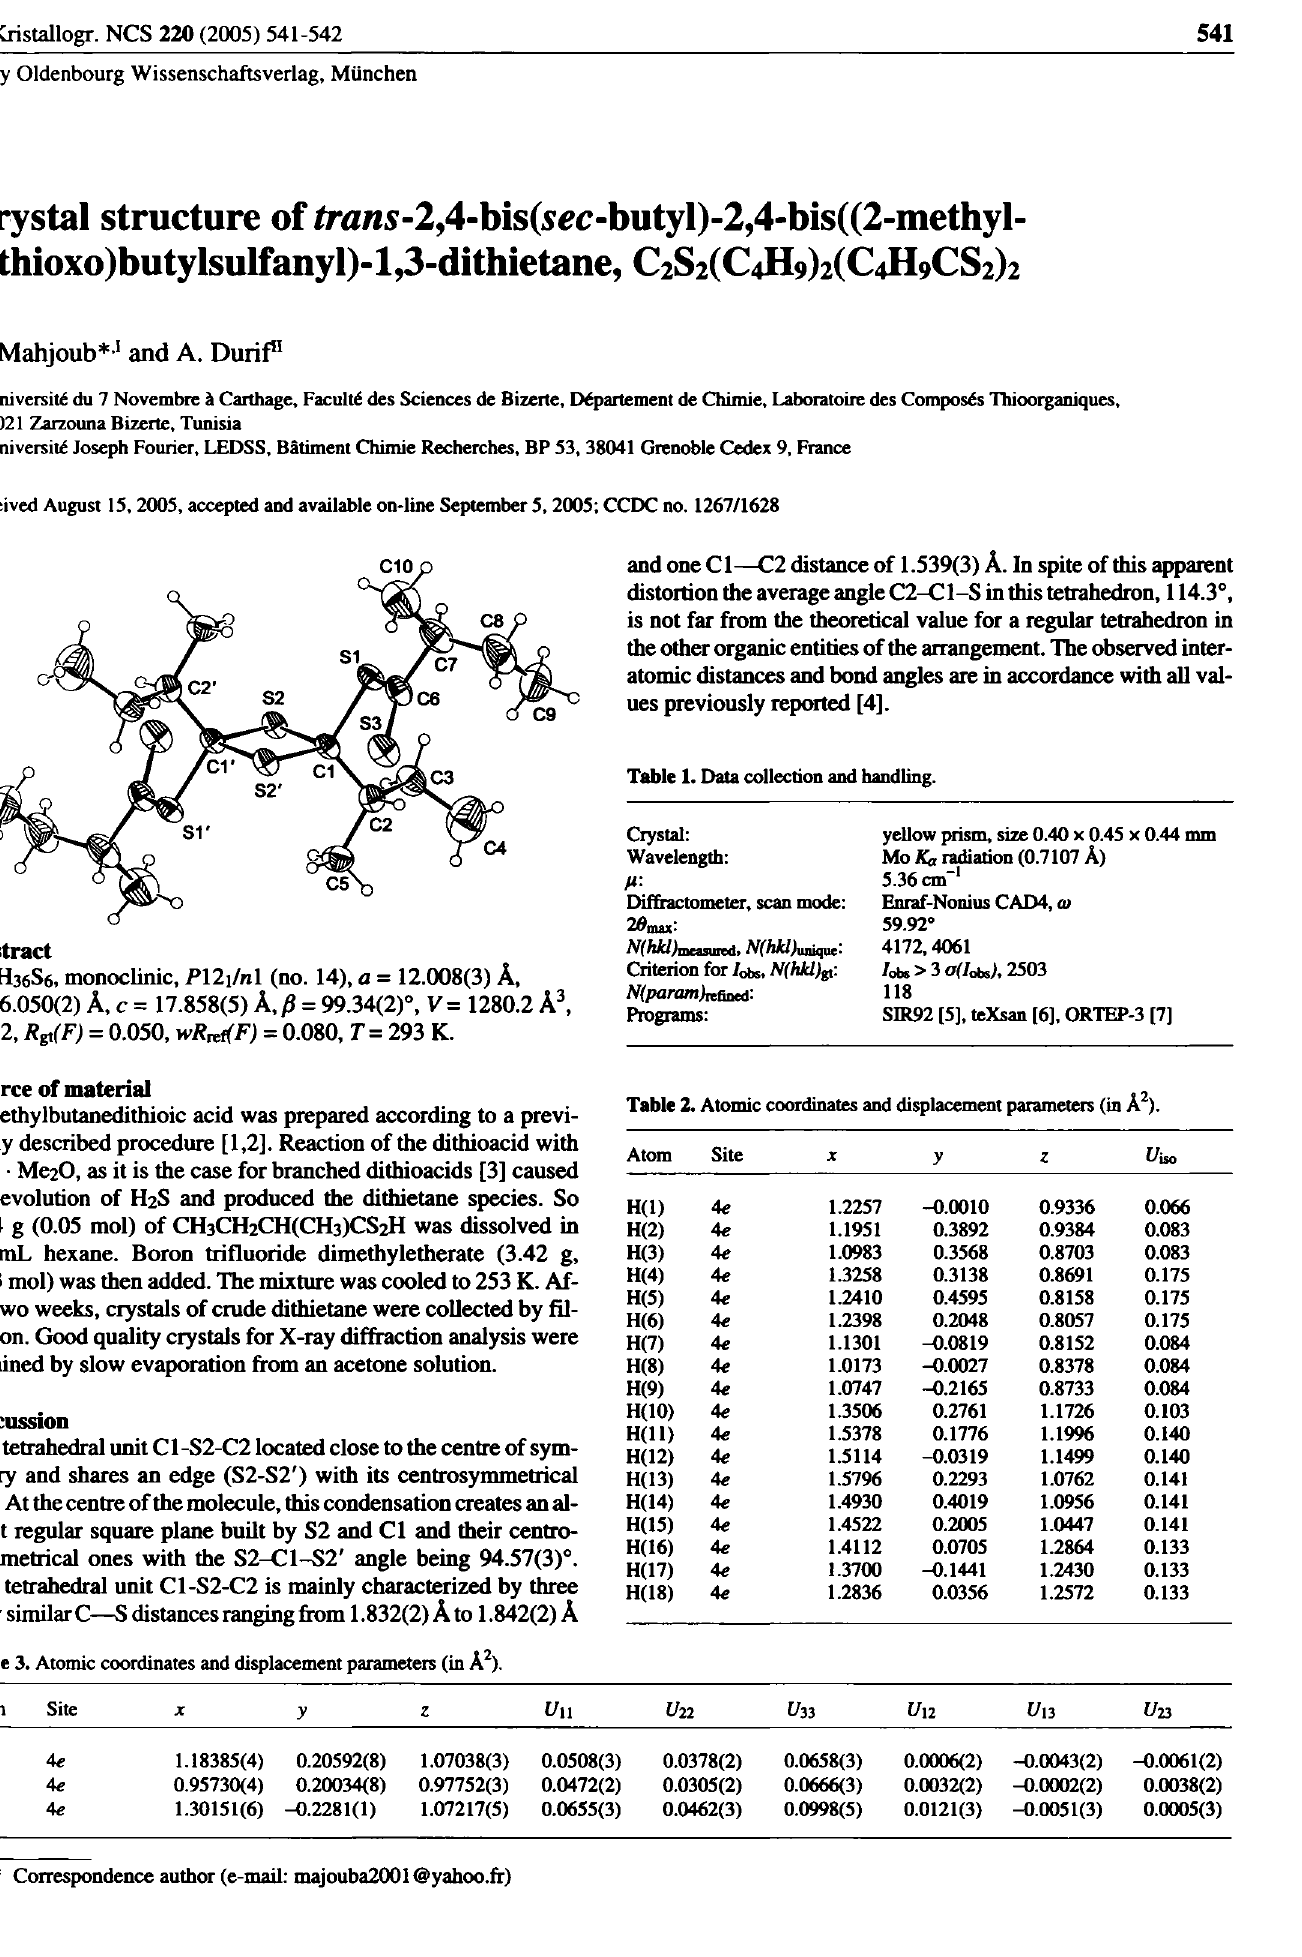
Table 3. Atomic coordinates and displacement parameters (in A 2 ).